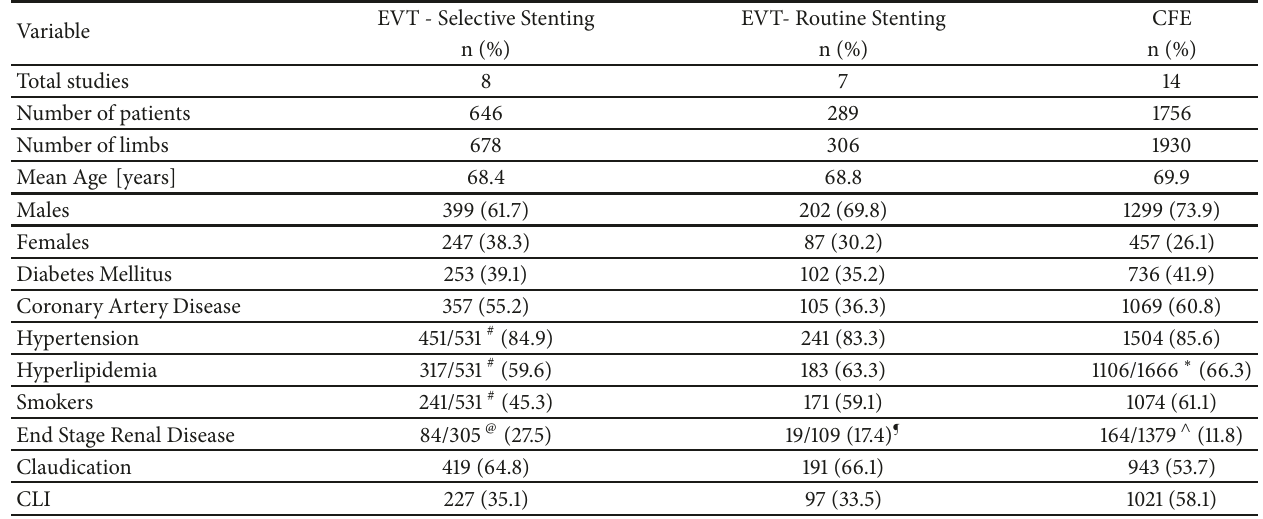
Table 1: Baseline demographics and comorbidities of patients in the different treatment groups.